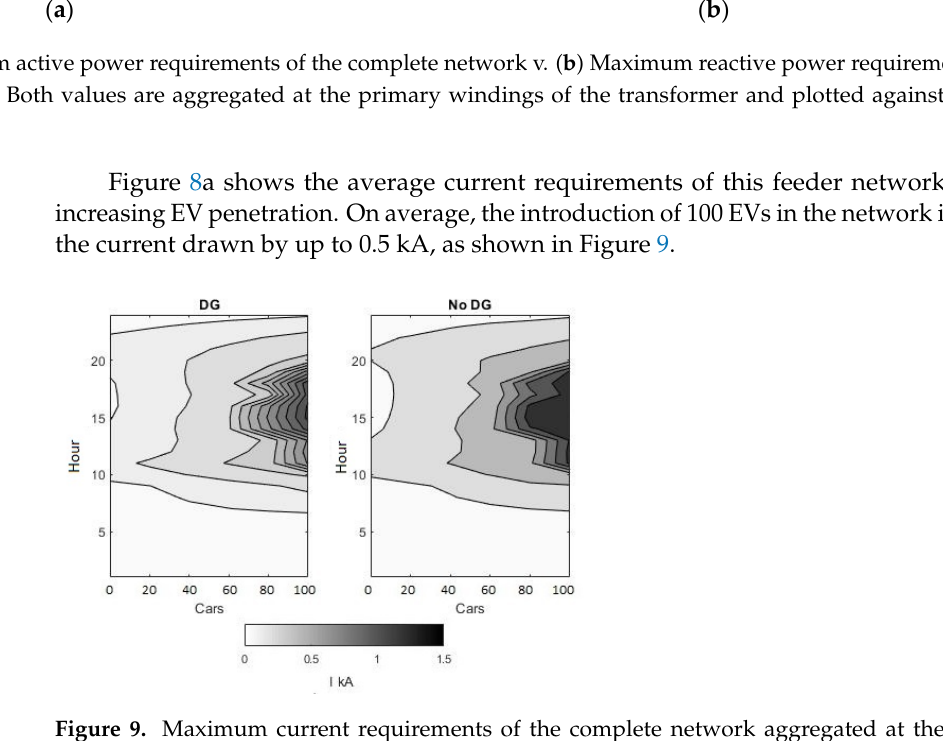
Figure 9. Maximum current requirements of the complete network aggregated at the primary windings of the transformer and plotted against EV penetration.